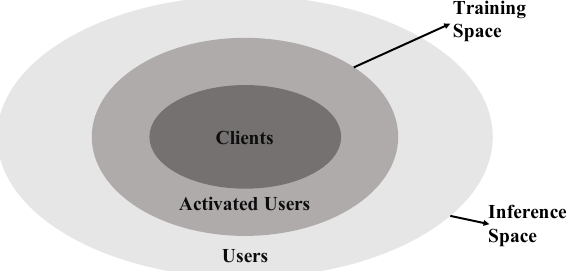
Fig. 2 SSB problem. Training space is composed of activated users. It is only a small part of the inference space, which is composed of